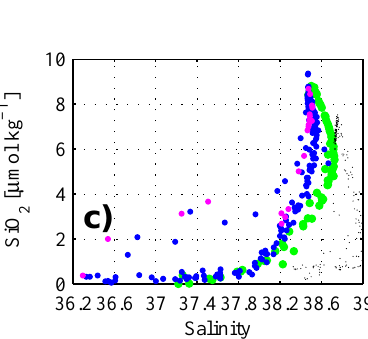
in µmol kg − 1 ) vs. salinity. 2